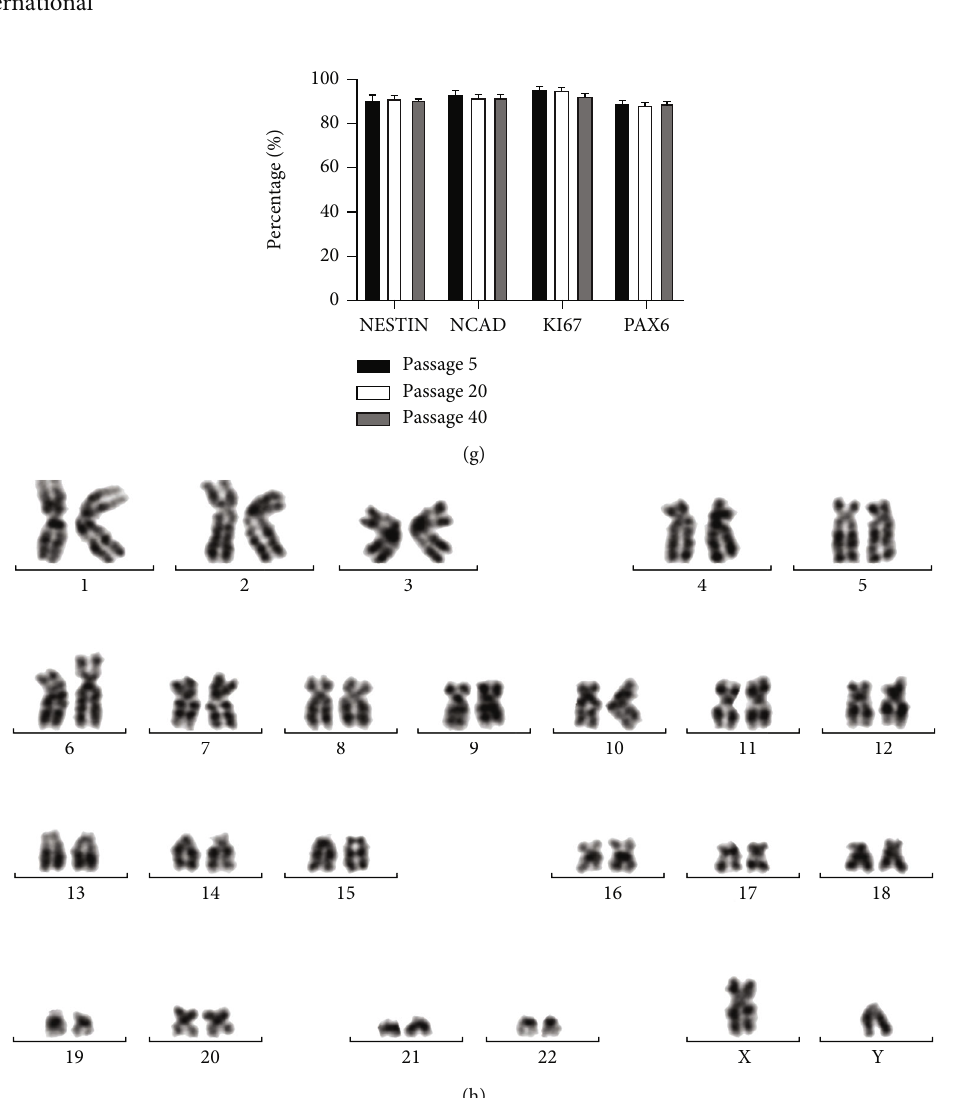
Figure 1: PBMNCs are reprogrammed into iNSCs. (a) The fl owchart is about the procedure converting PBMNCs to iNSCs by using Sendai reprograming vectors expressing the Yamanaka factors. (b) Representative pictures of cells at di ff erent time points. Scale bars, 200 μ m. (c) A representative picture of the induced iNSCs cultured as a monolayer. Scale bars, 200 μ m. (d) A representative picture of the induced iNSCs cultured as spheres. Scale bars, 500 μ m. (e) One-week expansion curves of iNSCs of passage nos. 10, 20, and 30. (f) iNSCs stained positive for markers SOX2, N-CADHERIN (NCAD), PAX6, NESTIN, ZO-1, and KI67. Scale bars, 50 μ m. (g) Percentages of iNSCs at passage nos. 5, 20, and 40 that were positive for NESTIN, NCAD, KI67, and PAX6, respectively. (h) Karyotype analysis of